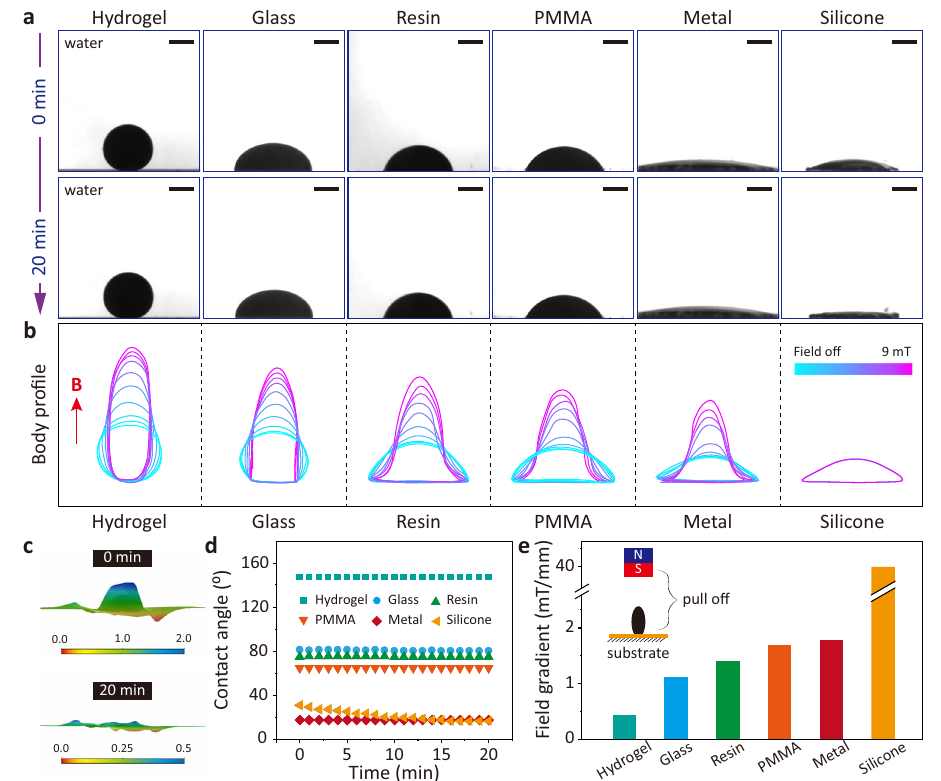
Fig. 2 | Wetting dynamics of the ferro fl uid droplet. a Images of ferro fl uid dro- plets(2 μ L)ondifferentsubstrates(hydrogel,glass,resin,polymethylmethacrylate (PMMA), metal (copper), silicone) at 0 min and 20 min after the dripping. b The overlapped body pro fi les of ferro fl uid droplets on different substrates as the uni- form magnetic fi eld strength is increased from magnetic fi eld off to 9 mT. The red arrowindicatesthedirectionofthemagnetic fi eld.Colorbarrepresentsnormalized magnetic fi eld strength. c The morphology of a ferro fl uid droplet at different